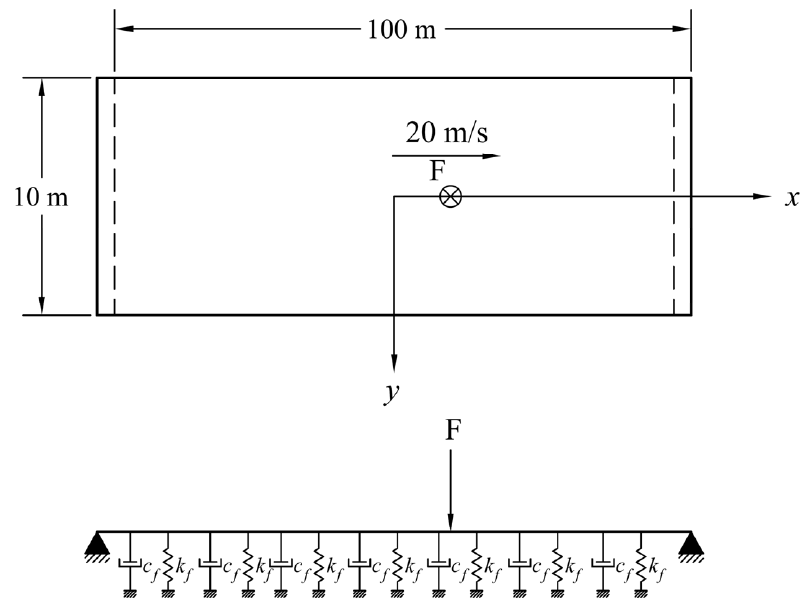
Figure 2. Schematic representation of the benchmark example problem.